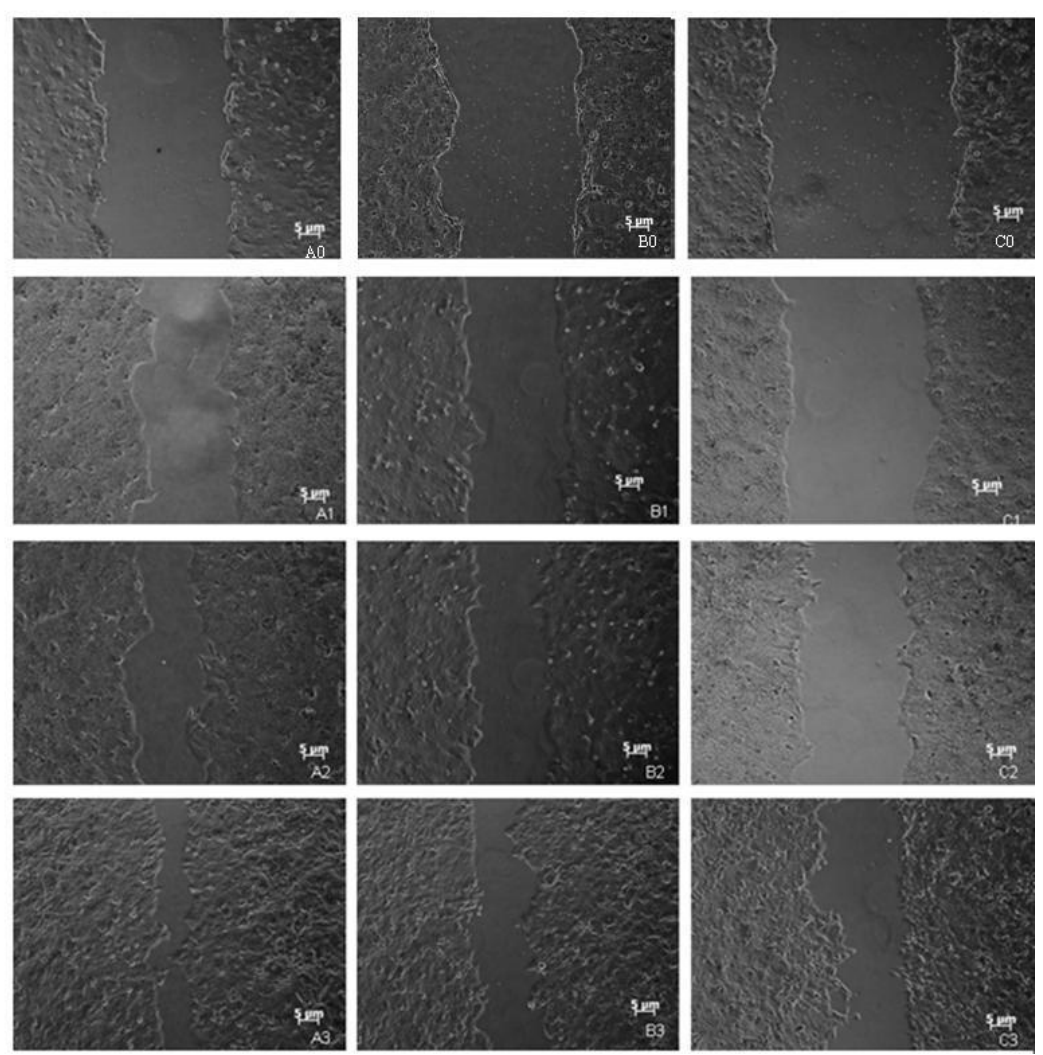
Figure 3. Wound distance analysis via scratch wound assays. A0 , A1 , A2 , A3 : images of control cells incubated for 0, 24, 48, and 72 h (50×); B0 , B1 , B2 , B3 : images of EGFP-C1 recombinant plasmid transfected cells incubated for 0, 24, 48 and 72 h (50×); C0 , C1 , C2 , C3 : images of EGFP-C1-HSPC117 recombinant plasmid transfected cells incubated for 0, 24, 48, and 72 h (50×).